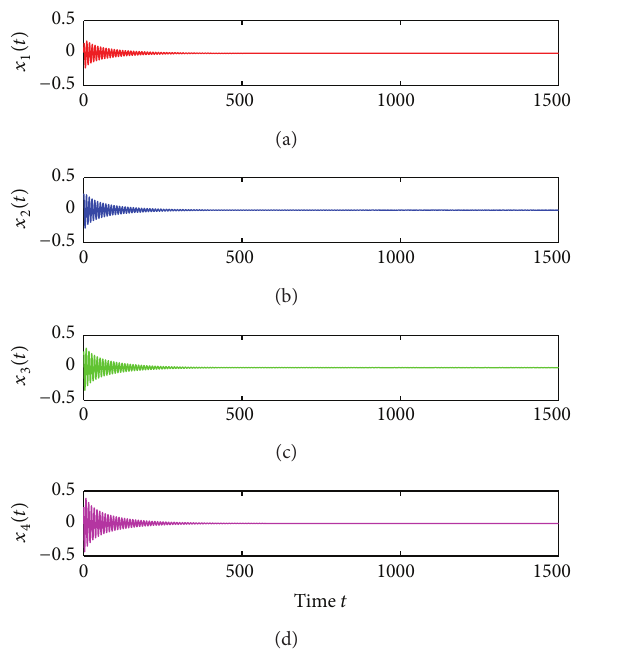
Figure 7: The trajectory of 𝑥 1 , 𝑥 2 , 𝑥 3 , and 𝑥 4 when 𝜏 2 = 3.5 > 3.1610 = 𝜏 20 .